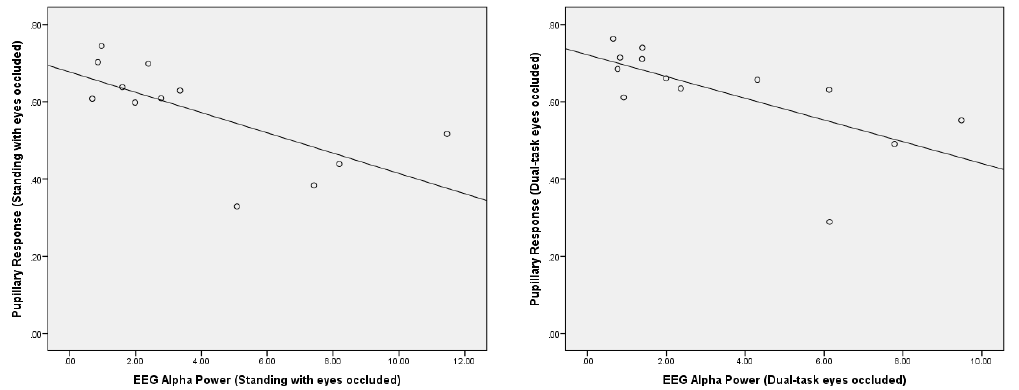
Figure 6. Correlation analysis between the pupillary response and EEG posterior alpha power (µV 2 /Hz) during standing with eyes occluded ( r = − 0.69, p = 0.01) and dual-task eyes occluded ( r = − 0.67, p = 0.01).